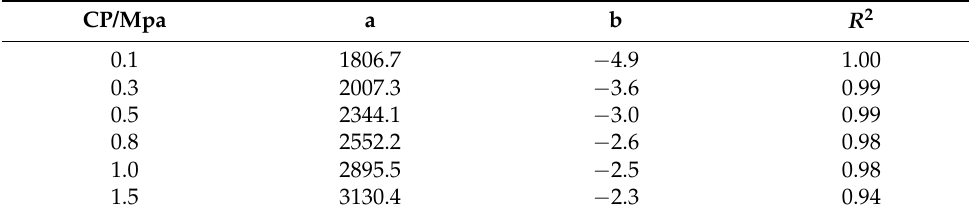
Table 4. Calculation of parameter a and b values.